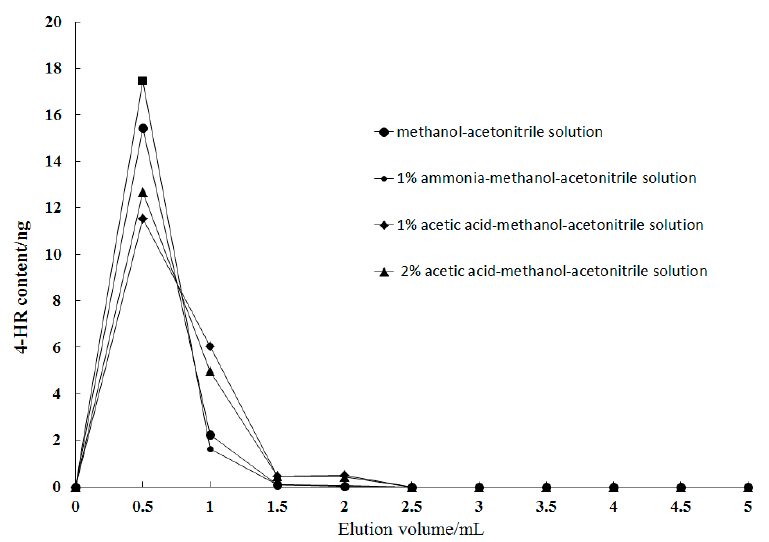
Figure 4. Effect of different elution solvents and elution volumes on the elution efficiency of